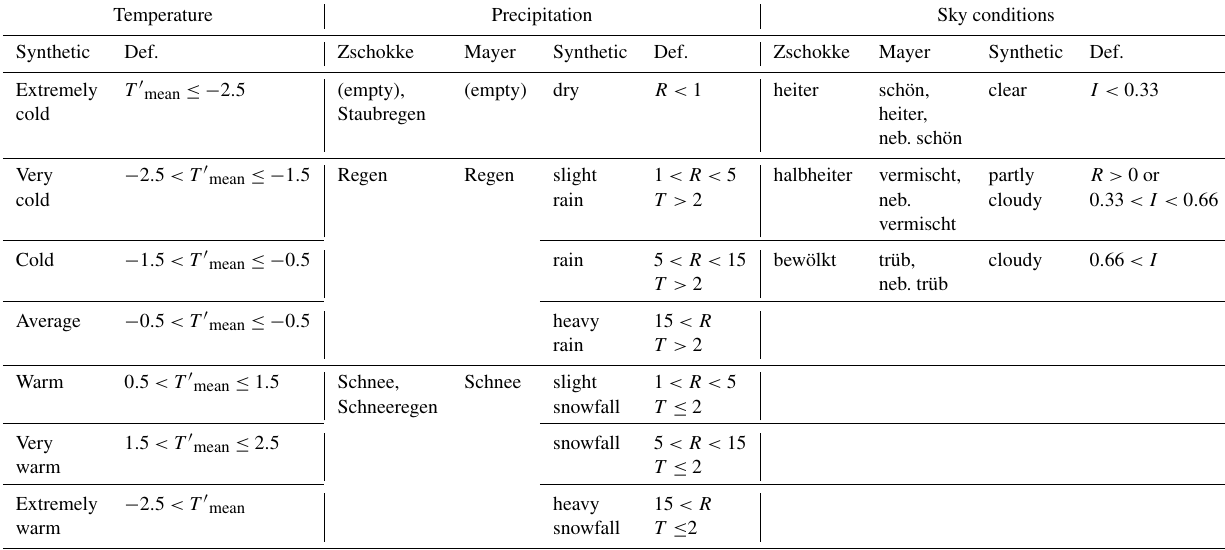
Table 2. Taxonomy used in the observations from Zschokke and Mayer as well as in the synthetic weather diary, together with the definition (def.; T : daily mean temperature in ◦ C; T (cid:48) : standardised daily mean temperature anomaly; R : precipitation in millimetre per day; I : irradiance relative to possible irradiance).